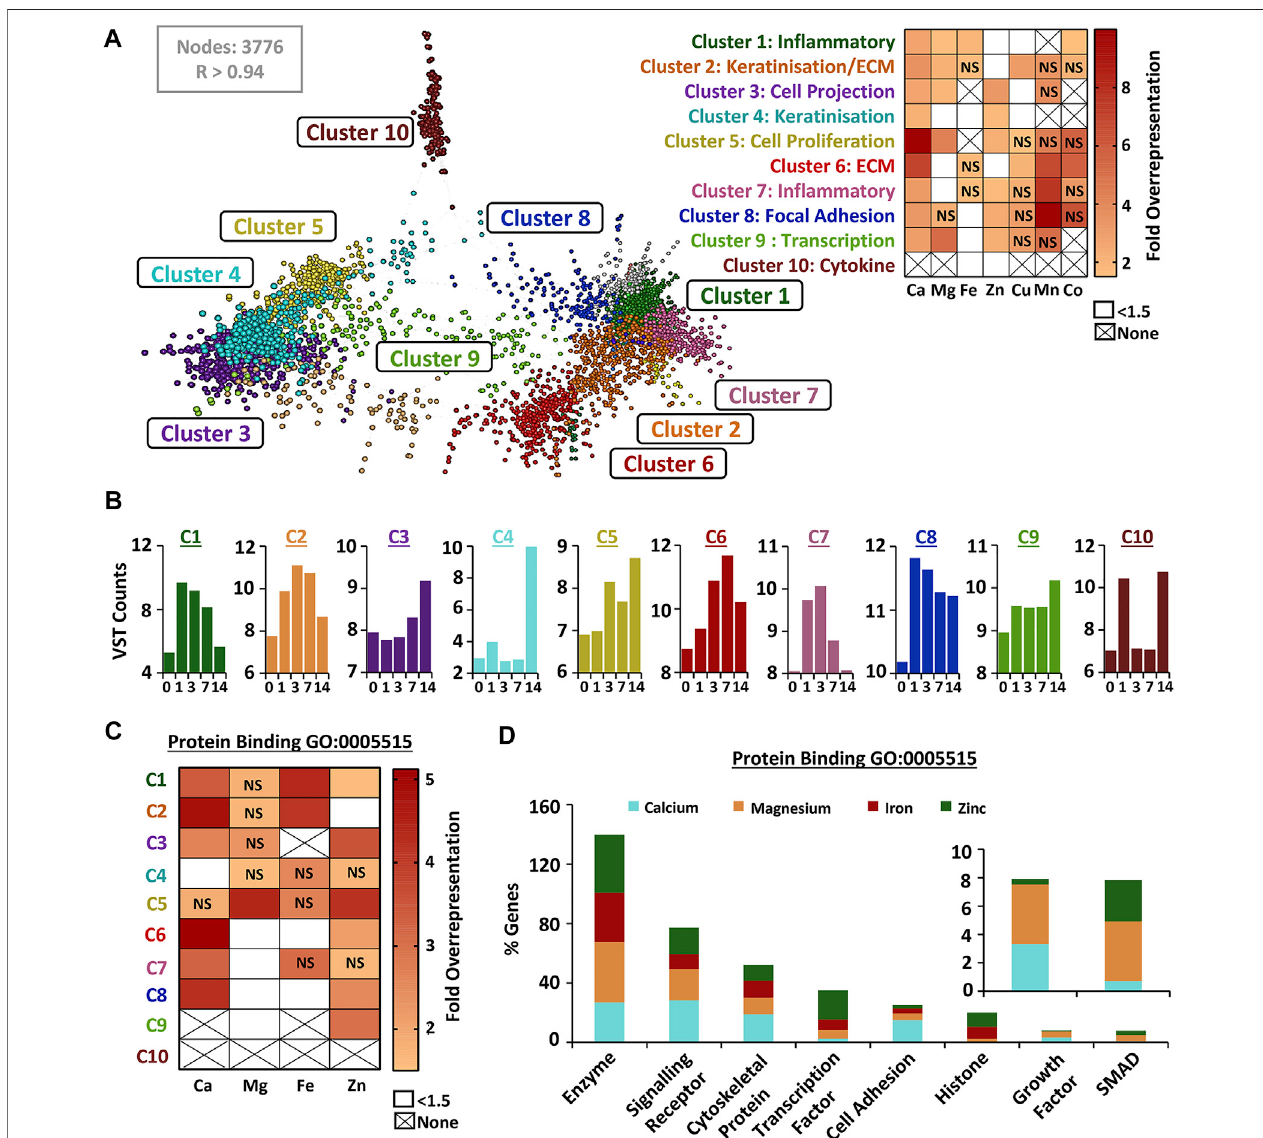
FIGURE4| Wound-inducedgenesclusterbybiologicalfunctionandshowprocess-speci fi cmetaloverrepresentation.Woundupregulateddifferentiallyexpressed genes (DEGs) were clustered (A) by similarity in expression signatures (VST data) using a Markov clustering algorithm. Clusters named based on functional annotation. Overrepresentation of UniProt Knowledge Base metal genes in de fi ned clusters (heat map, right). Expression pro fi le for each cluster shown in (B) . Overrepresentation performed on metal-linked genes from the protein binding gene ontology (GO) group (GO:0005515) in (C) , with speci fi c subset contribution in (D) . NS, non- signi fi cant; None, no genes in metal group; VST, variance stabilised transformation; R, Pearson ’ s correlation.